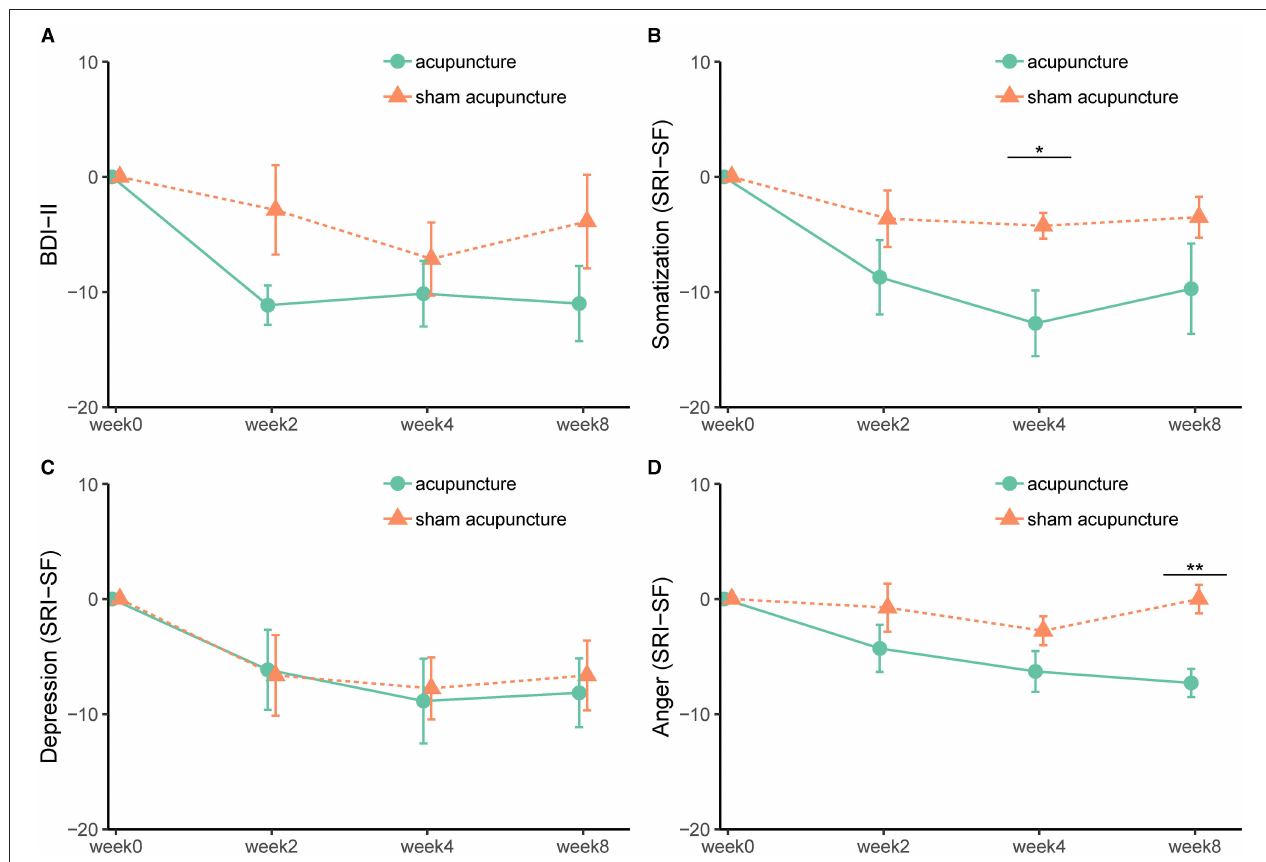
FIGURE 2 | (A-D) Effect of acupuncture and sham acupuncture on BDI-II and SRI-SF subscales (somatization, depression, and anger). BDI-II, Beck Depression Inventory-II; SRI-SF, Stress Response Inventory-short form. *, < 0.05; **, < 0.01.